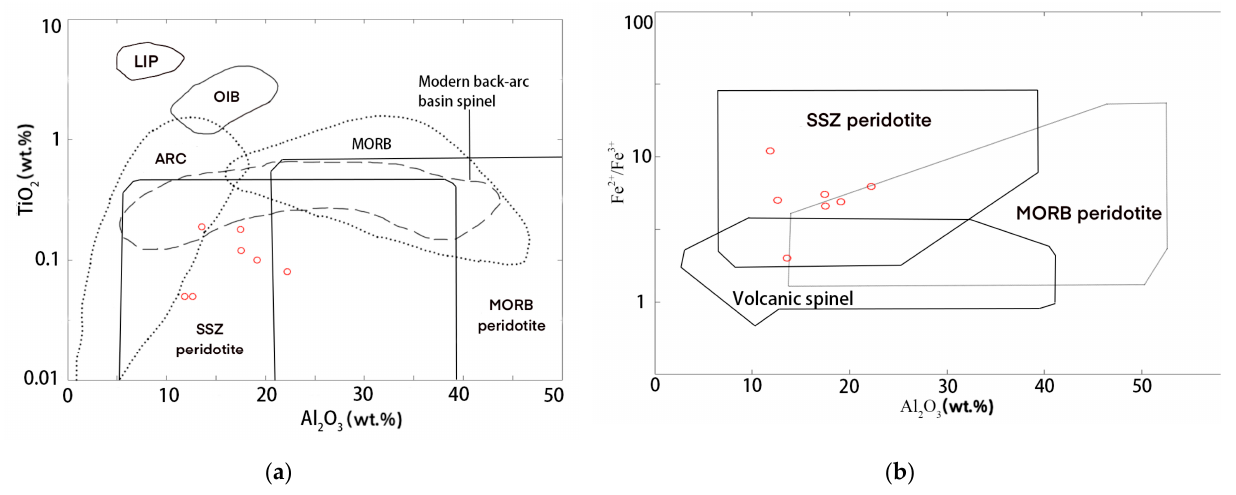
Figure 12. Discriminant graph of chromite [54] in “Laoshan Jade”: ( a ) Al 2 O 3 -TiO 2 graph; ( b ) Al 2 O 3 - Fe 2+ /Fe 3+ graph.